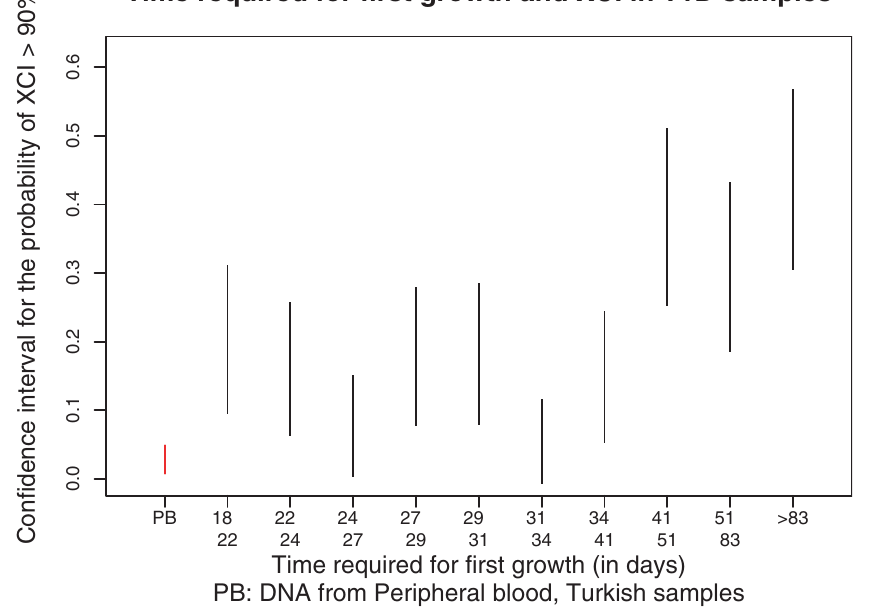
Figure 3. Confidence intervals for the probability of XCI . 90% as a function of the time required for first growth (ie. between transformation and until the culture volume reaches 100 ml).